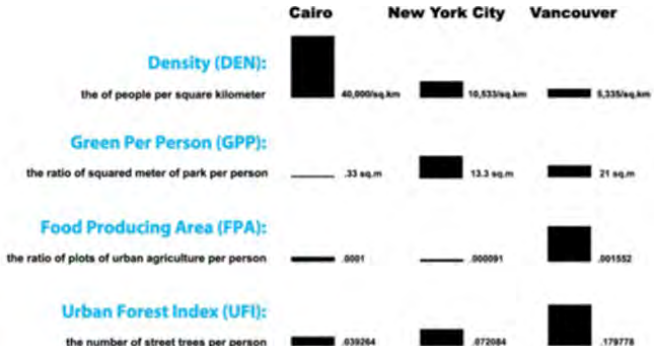
Figure 2. Comparison of density, greening, food production & urban forest between Cairo, New York city & Vancouver (Attia & Mahmoud, 2009)